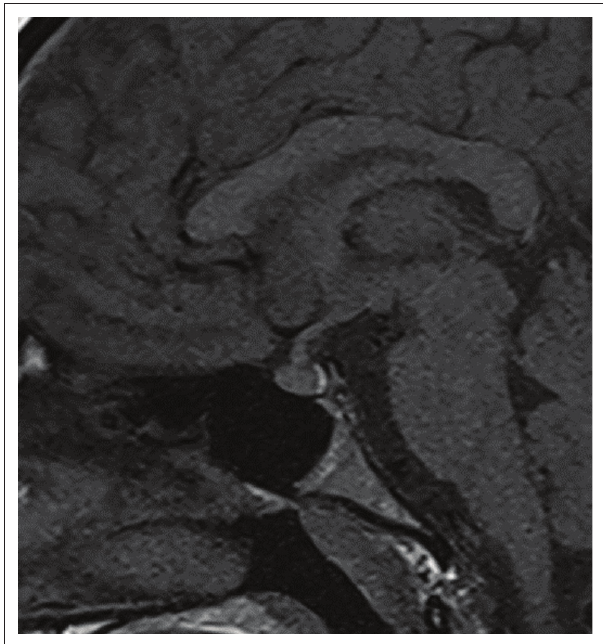
FIGURE 1: Unenhanced T1-weighted image reveals thickening of the pituitary stalk. The adeno and neurohypophysis are visualised in their normal intrasellar